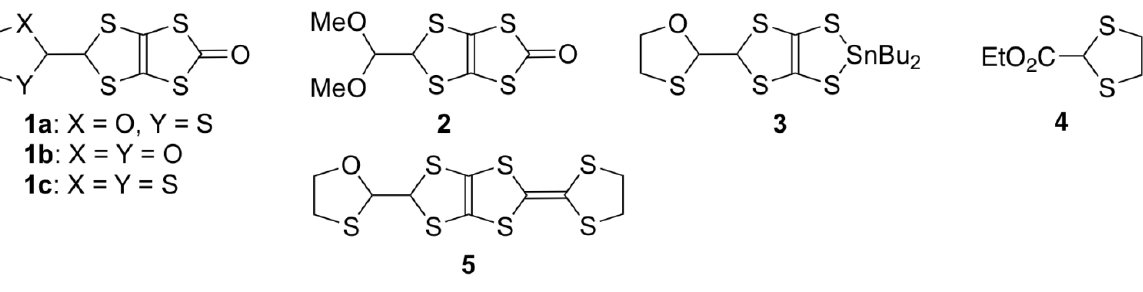
Figure 14. ( a ) Top and ( b ) side views of the molecular structure of DHOT-TTP (Reprinted with permission from reference 39, The Chemical Society of